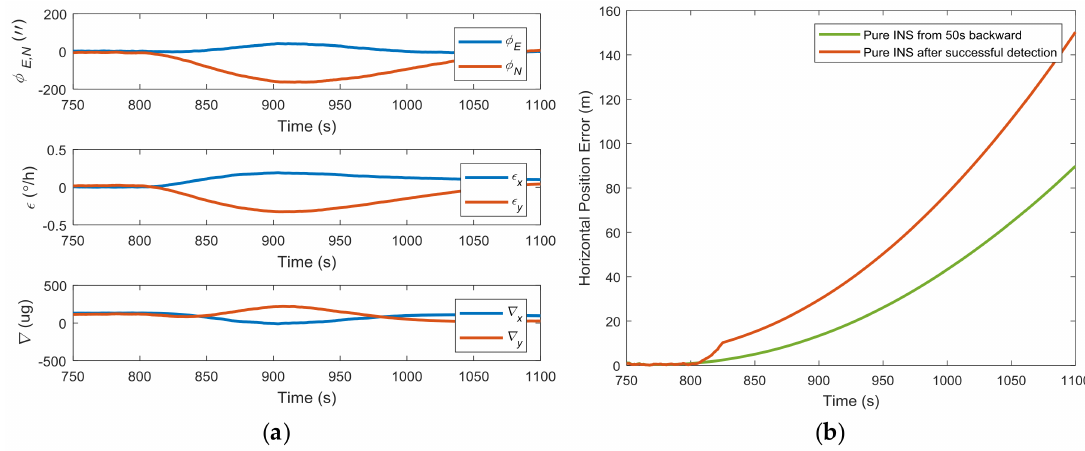
Figure 6. ( a ) Inertial sensor bias estimation and misalignment angle under a 1 m/s synchronized spoofing attack; ( b ) horizontal position accuracy comparison between two pure INS